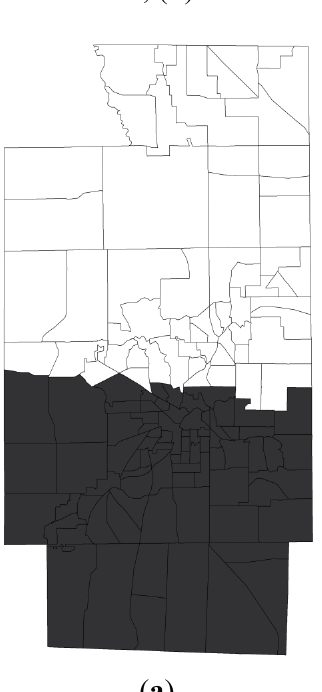
Figure 5. Spatial patterns of regression coefficients for median family income ($1000’s). ( a ) Census Tracts; ( b ) Census Block